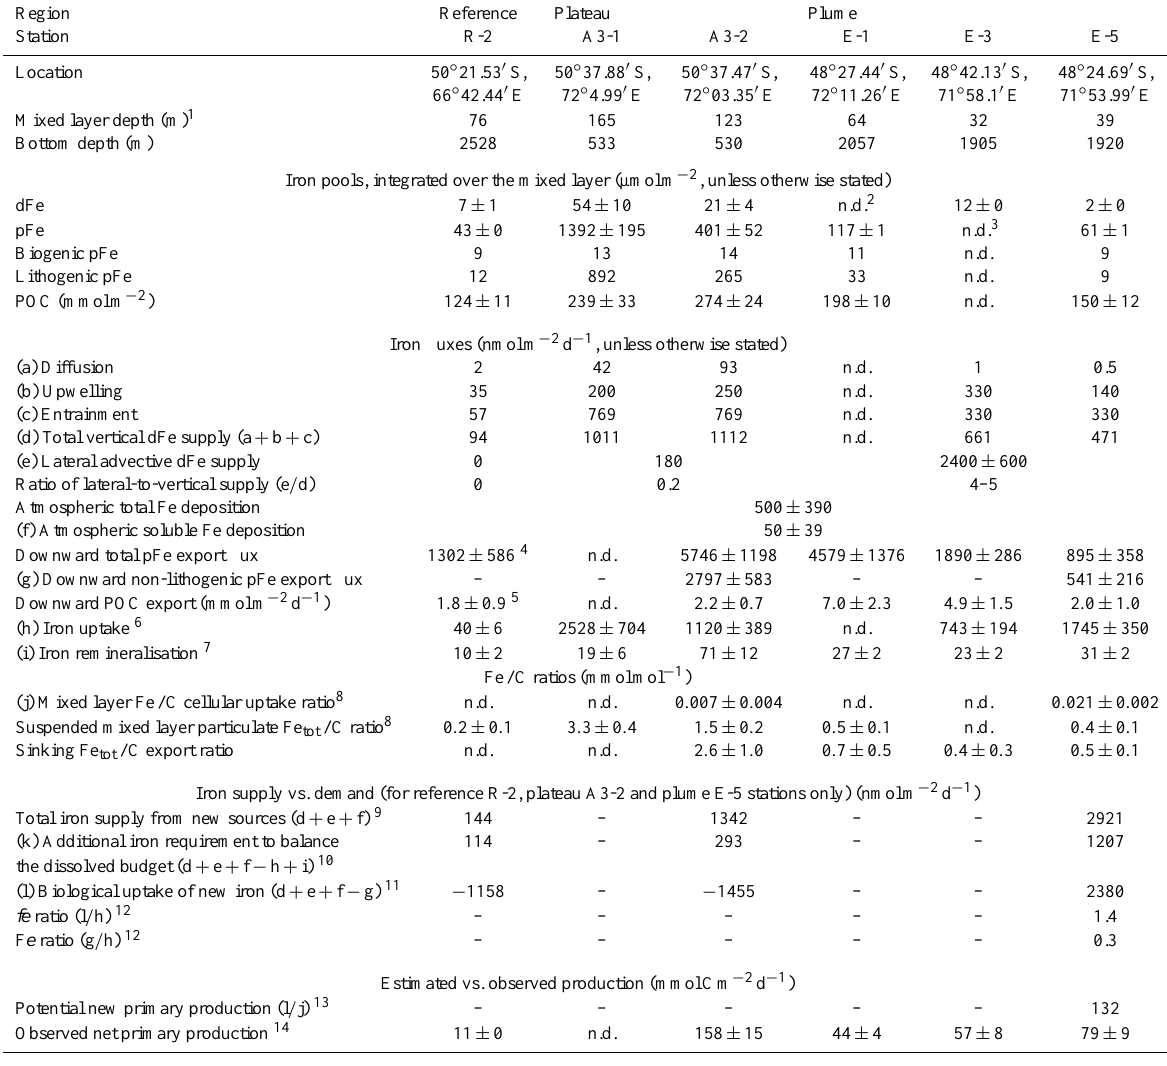
Table 1. Summary of iron standing stocks and fluxes for the upper mixed layer at KEOPS-2 process station sites R-2 (reference), A3 (plateau) and E (plume). For full details of the calculations, see text. Error bounds are provided where available. Due to logistical constraints resulting in missing data at some stations, we will focus on R-2, A3-2 and E-5 in the discussion. Data for stations A3-1, E-1 and E-3 are given to provide a context for spatial and temporal changes in the pools and fluxes during